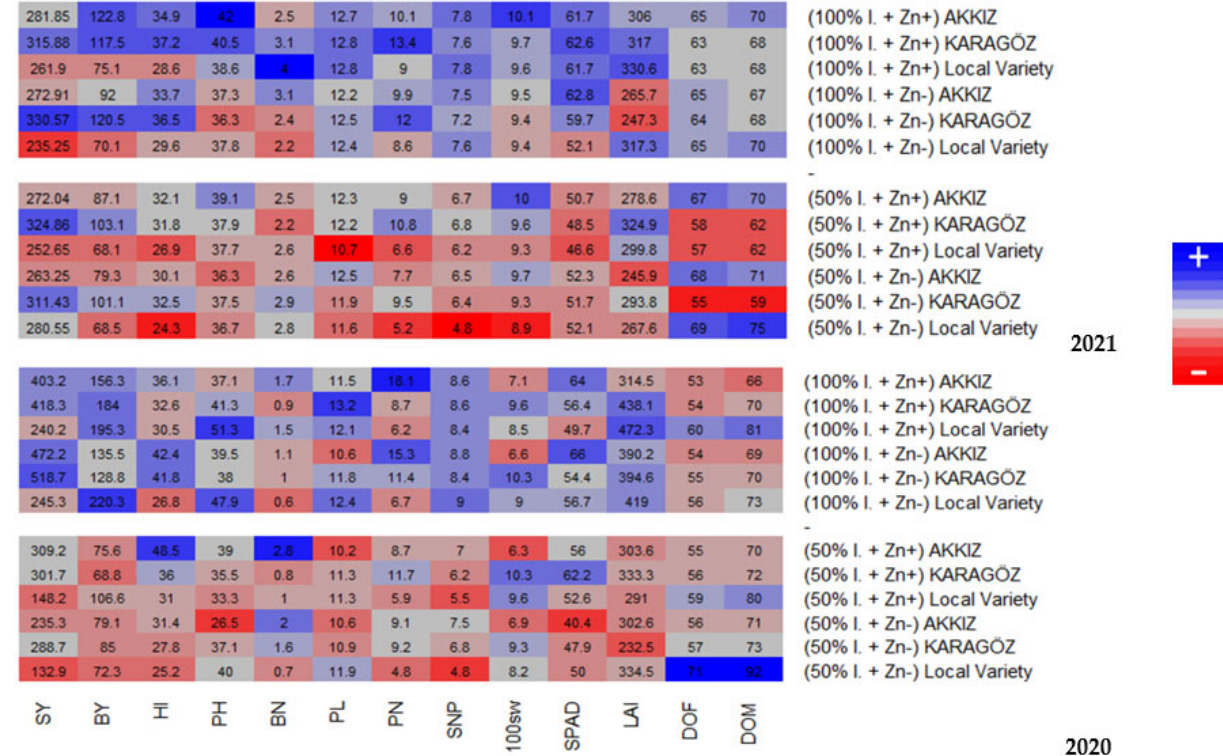
Figure 2. Mean values of grain yield and yield components.